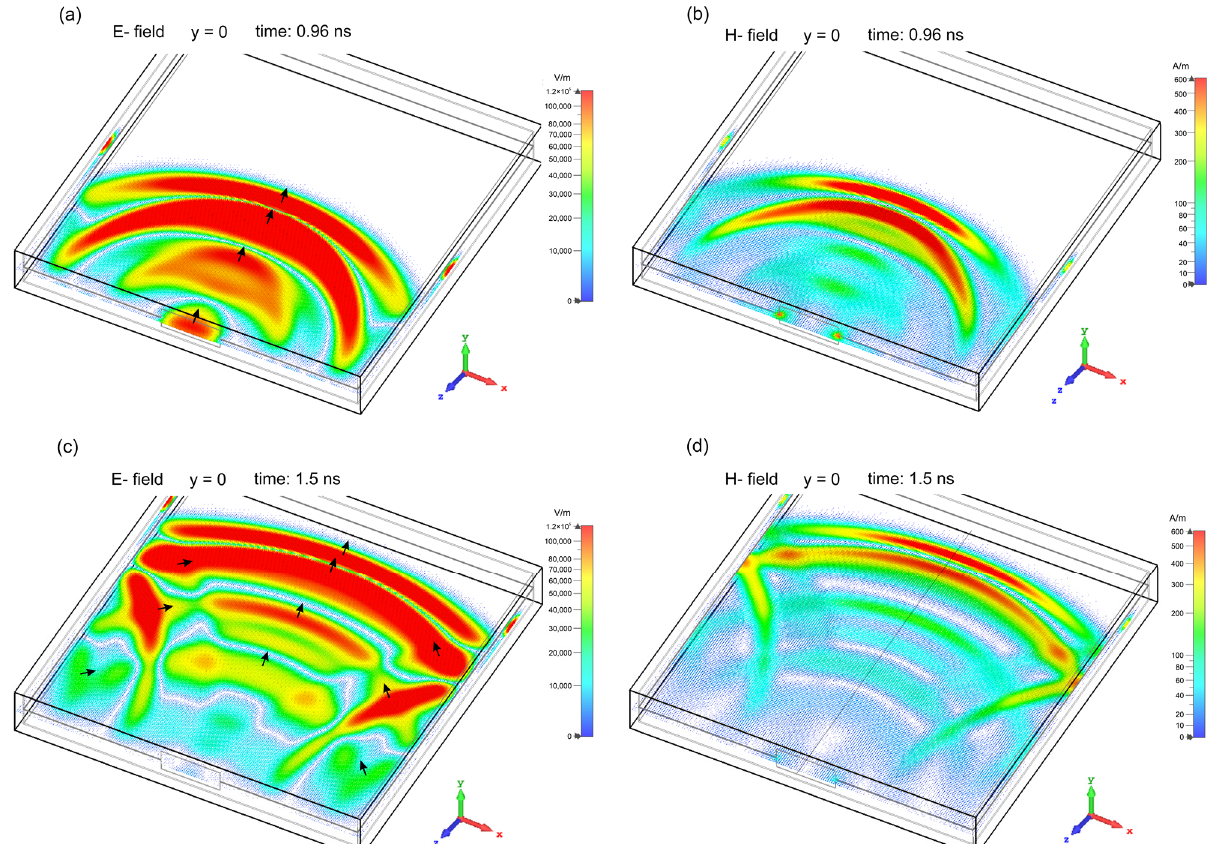
Figure 3. 2D images illustrating the development of the electric and magnetic fields in the wave phase in the enclosure at various times (at t = 0, the incident plane-wave pulse onset reaches the front plane of the enclosure). Left column —the electric field amplitude, right column —the magnetic field amplitude. Arrows show the propagation direction of the primary and secondary waves. ( a , b ) and ( c , d ) show the electric and magnetic fields at times t = 0.96 ns and t = 1.5 ns,